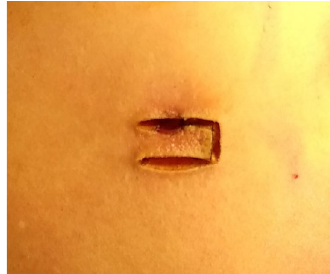
Figure 1. The skin was incised to create a rectangular skin bridge 2.5–3 cm long and 1–1.5 cm wide.